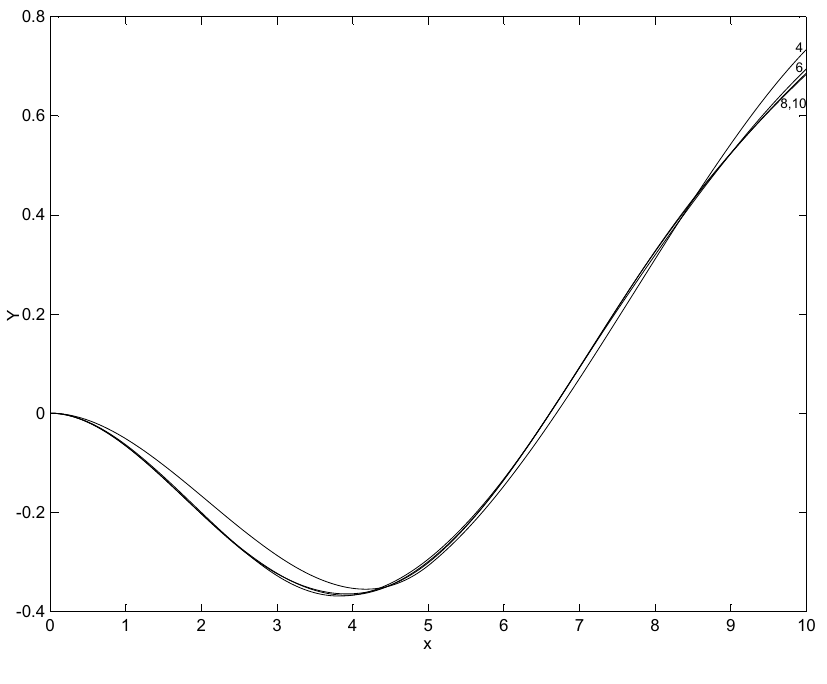
Fig. 5. FEM second eigenfunction convergence (4, 6, 8, 10